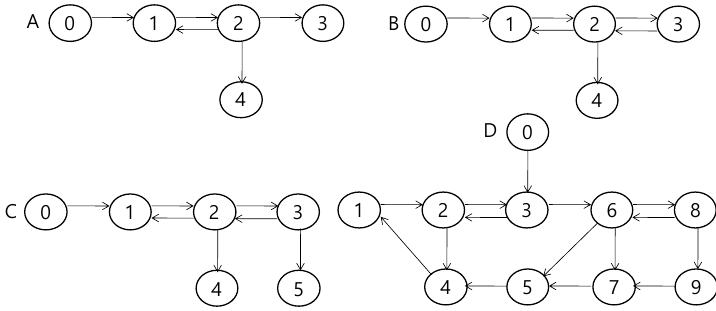
Figure 3. Communication graphs used for performance evaluation.